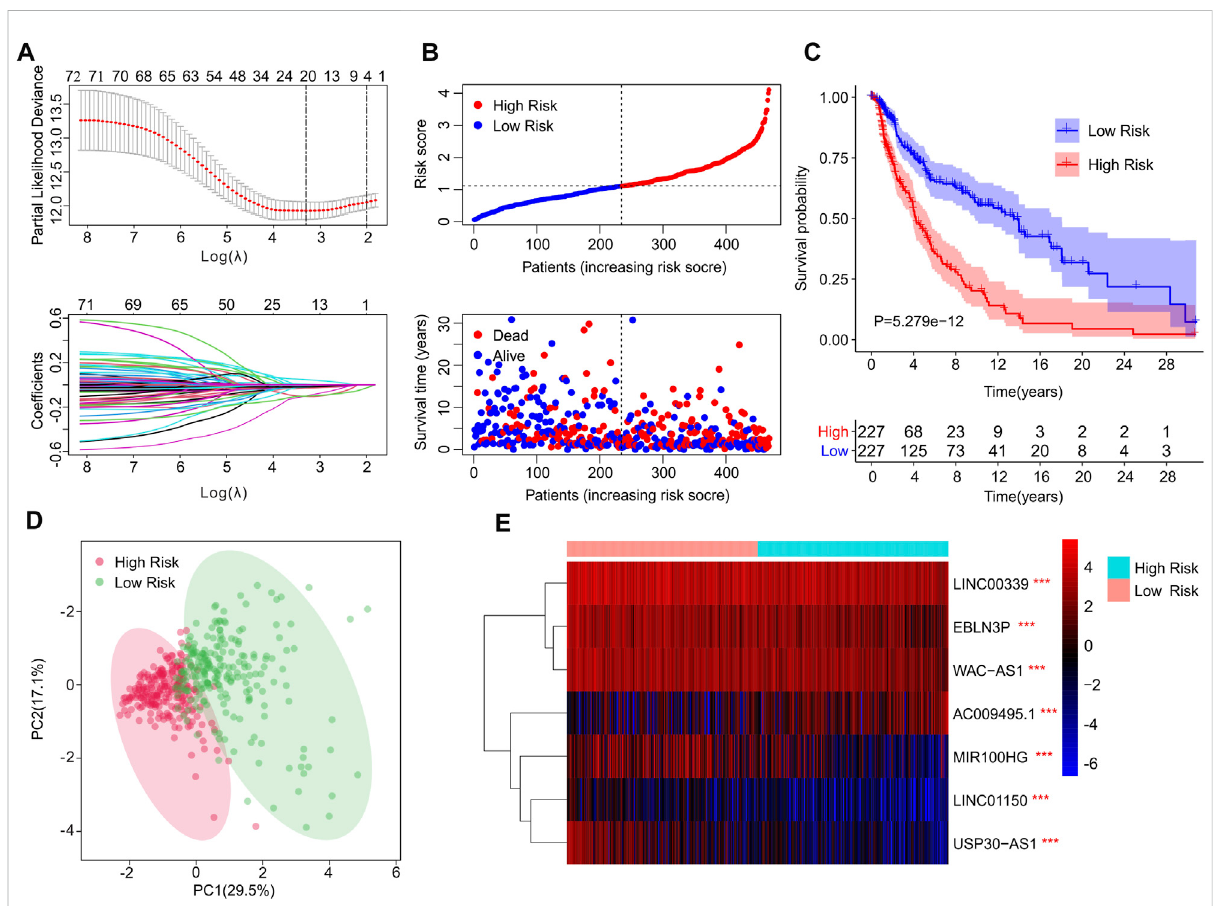
FIGURE 2 Risk model construction based on the prognostic cuproptosis-related lncRNAs of patients with CM. (A) LASSO showed the coef fi cients and minimal lambda of prognostic cuproptosis-related lncRNAs. (B) Distribution of risk scores of CM patients and scatter plot showed the correlation between cuproptosis-related lncRNAs prognostic features and survival time. (C) The Kaplan-Meier survival curve illustrated that the survival rate of patients in low-risk group was signi fi cantly longer than those in high-risk groups. (D) The principal component analysis (PCA) displayed a signi fi cant separation betweenlow- andhigh-riskgroups based ontheseven prognosticcuproptosis-related lncRNAs. (E) The heatmap visualresult demonstrated the expression of seven cuproptosis-related lncRNAs in low- and high-risk